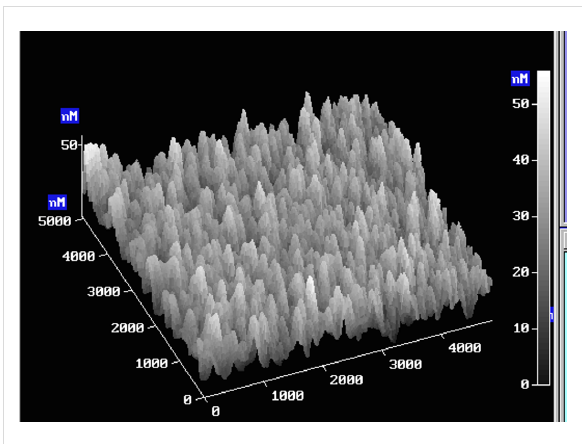
Figure 6: AFM topography image of an as-casted 1:1 P3HT: AIM 7 blended